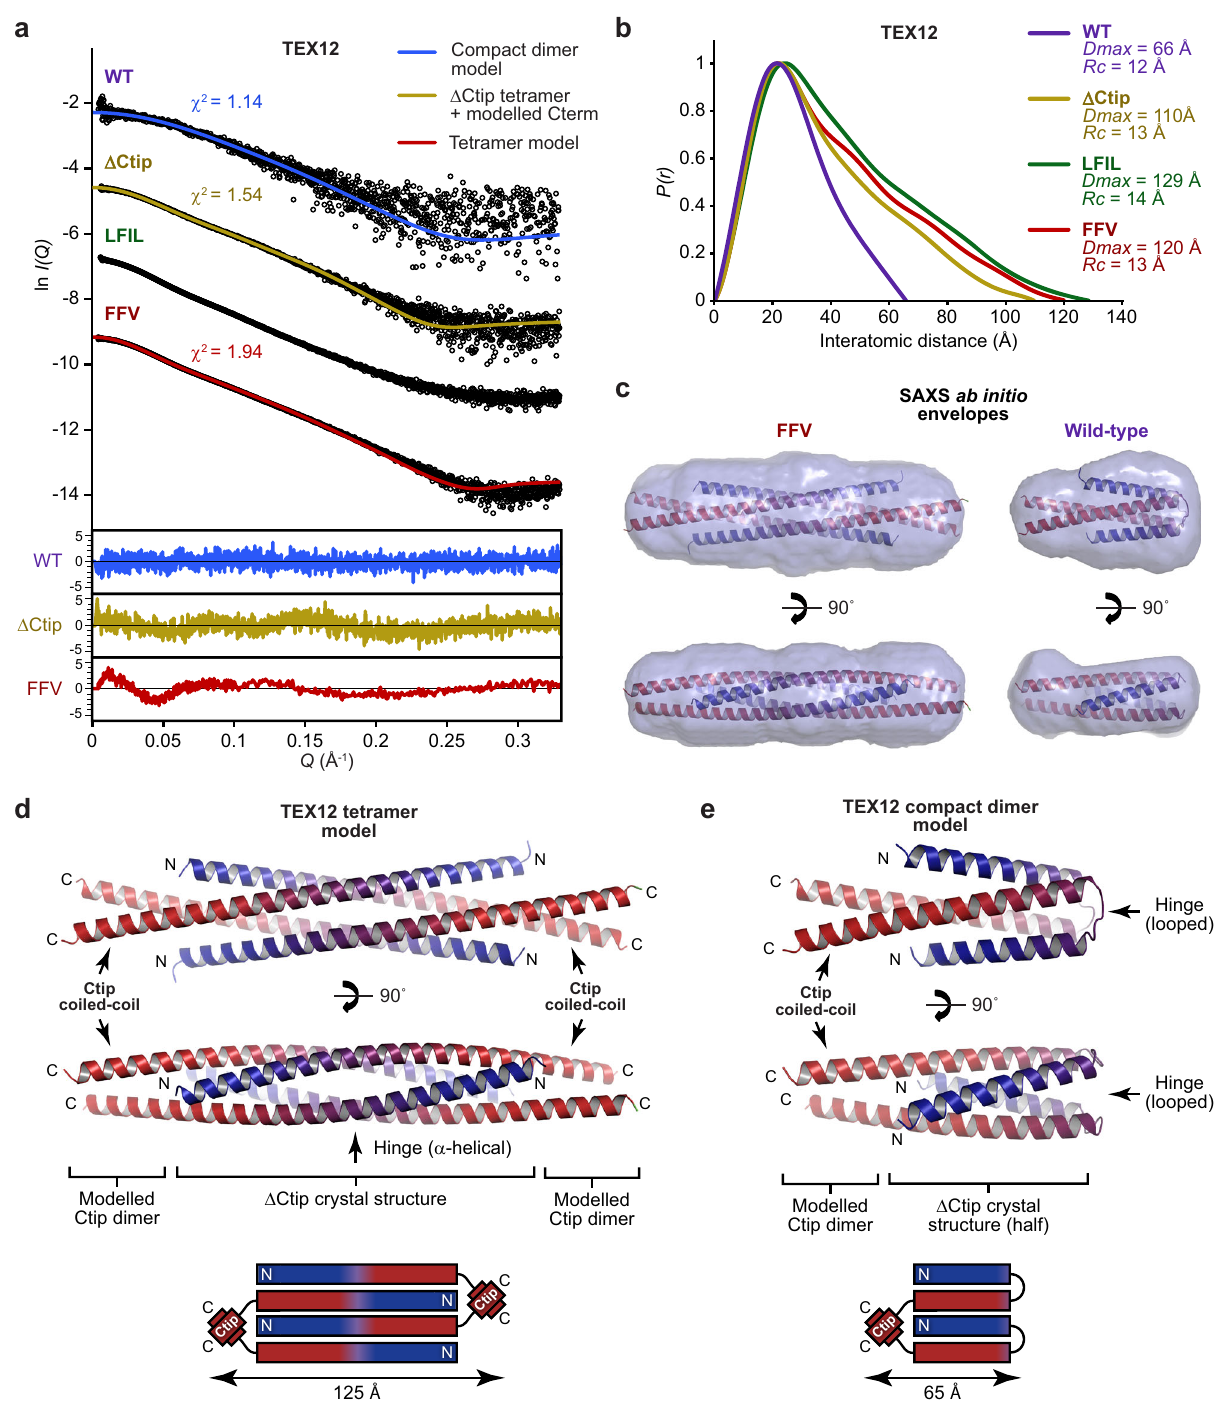
Fig. 6 TEX12 adopts a compact dimeric conformation in solution. a – c SEC-SAXS analysis of TEX12 core wild-type (blue), Δ Ctip (yellow), LFIL (green) and FFV (red). a SAXS scattering data overlaid with the theoretical scattering curves of the compact dimer model, Δ Ctip tetramer structure with modelled C-terminus and tetramer model for wild-type, Δ Ctip and FFV, respectively; χ 2 values are indicated and residuals for each fi t are shown (inset). b SAXS P(r) inter-atomic distance distributions in which maximum dimensions ( Dmax ) are indicated, along with cross-sectional radii ( Rc ) determined from Guinier analysis (Supplementary Fig. 3a, b). c SAXS ab initio models of FFV and wild-type TEX12. Filtered averaged models from 30 independent DAMMIF runs are shown with the TEX12 tetramer and compact dimer models docked into the SAXS envelopes. d Theoretical model of the TEX12 tetramer structure (corresponding to FFV) in which parallel dimeric coiled-coils of Ctip sequences were docked onto the core Δ Ctip crystal structure to form an extended molecule of 125 Å length. e Theoretical model of the TEX12 compact dimer consisting of one-half of the tetramer model in which N- and C-terminal helices were joined by modelling the hinge in an alternative conformation of fi ve amino-acid loops; the length of the theoretical compact dimer structure is 65